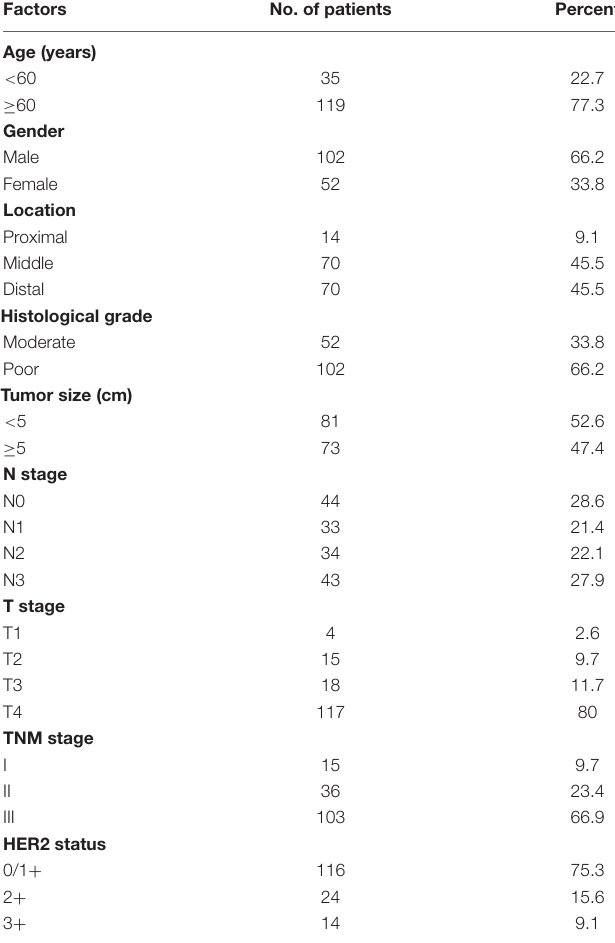
TABLE 1 | Clinicopathological characteristics of 154 GC